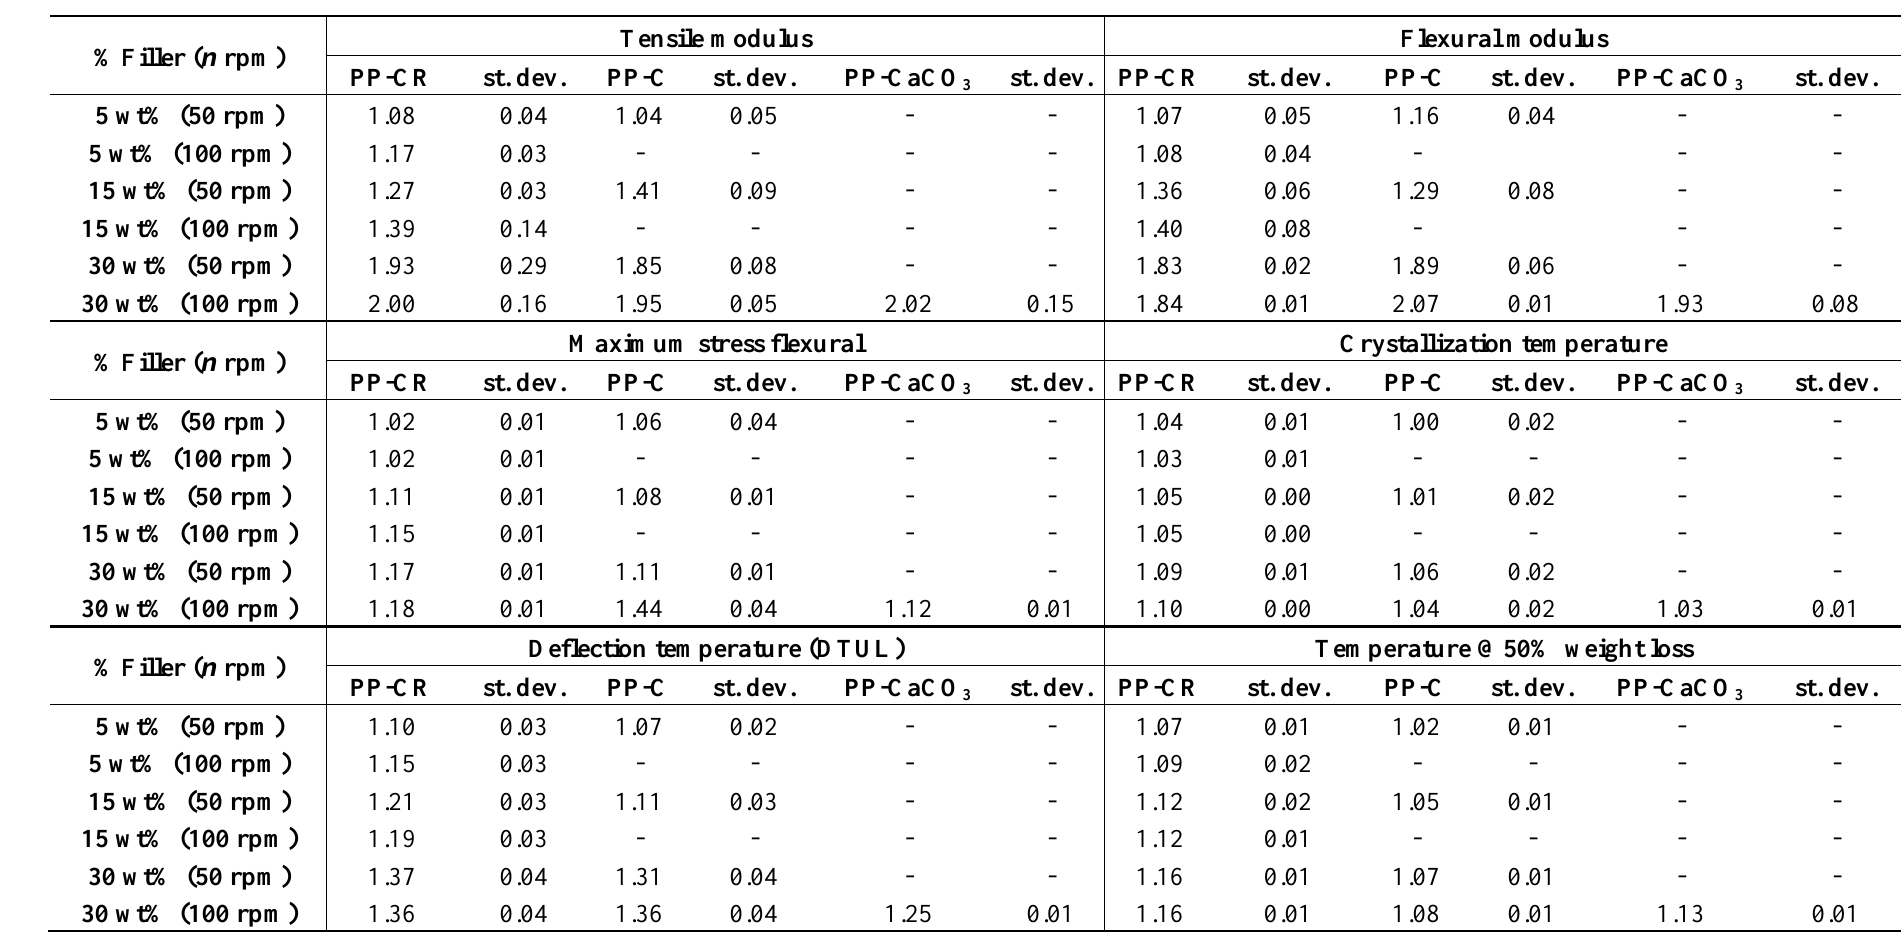
Table 1. Tensile and flexural modulus, maximum stress (flexural), crystallization temperature behavior, deflection temperature under load (DTUL), and temperatures corresponding to the 50% of weight loss, for rice husk silica based (CR), colloidal silica based (C) and CaCO based composites varying processing conditions (the values are normalized in respect to the pristine polypropylene (PP)). A minimum of 5 specimens have been tested for each sample evaluating the average value and the experimental standard deviation (st.